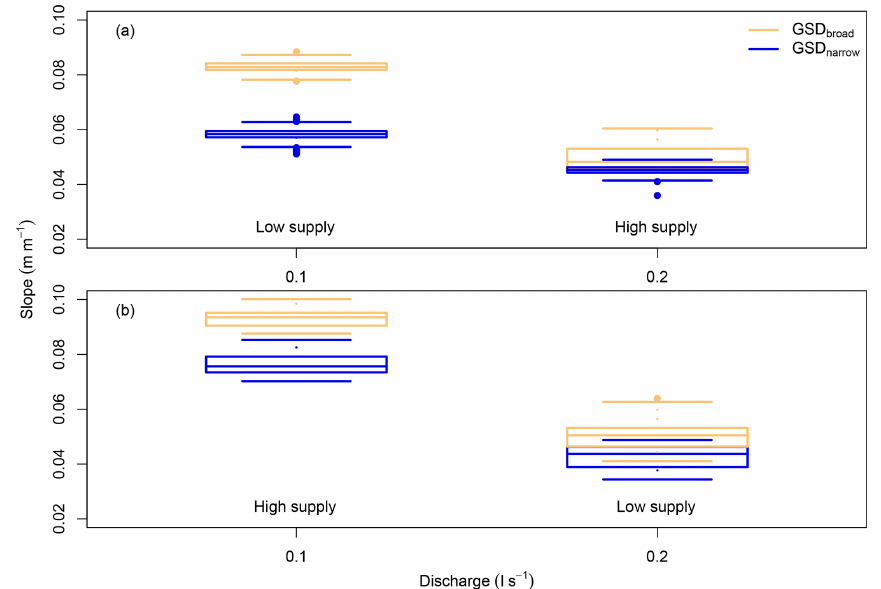
Figure 6. Distribution of slope values from the onset of transport onwards. Plots separate experiments by relative sediment concentrations of (a) 1 and (b) not 1 (i.e. 0.5 or 2). Text indicates sediment feed rate (low supply = 1gs − 1 , high supply = 2gs − 1